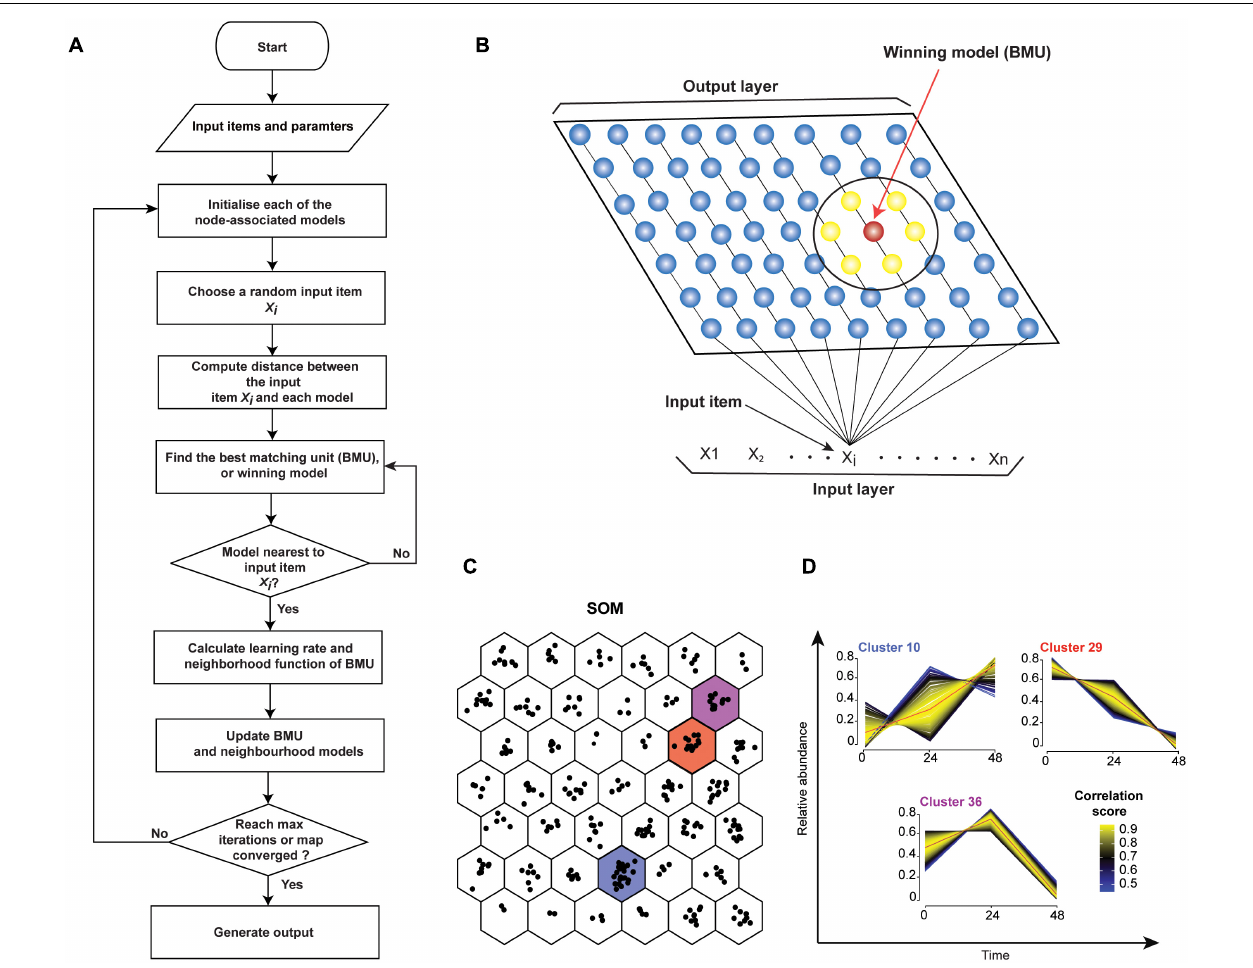
FIGURE 5 | Self-Organizing Map (SOM). (A) Flowchart of a sequential SOM algorithm. (B) SOM input and output layers. Input items (x 1 - x n ) will be compared individually to models/nodes. The red model represents the best match, and the surrounding models (yellow, within the larger circle) are its neighbors. (C) Mock 3-time-point data was grouped into 42 clusters in a hexagonal 6 × 7 output grid using SOM. Points in each hexagon represent proteins. (D) Temporal profiles of proteins from panel (B) clusters 10, 29, and 36 are shown. Profile colors reflect the correlation of the protein profiles to cluster’s centroid (red line). This can help to select or filter proteins from clusters. Proteins with similar profiles to the cluster’s centroid have the correlation score approaching 1 (yellow), while those with divergent patterns have a correlation score closer to 0